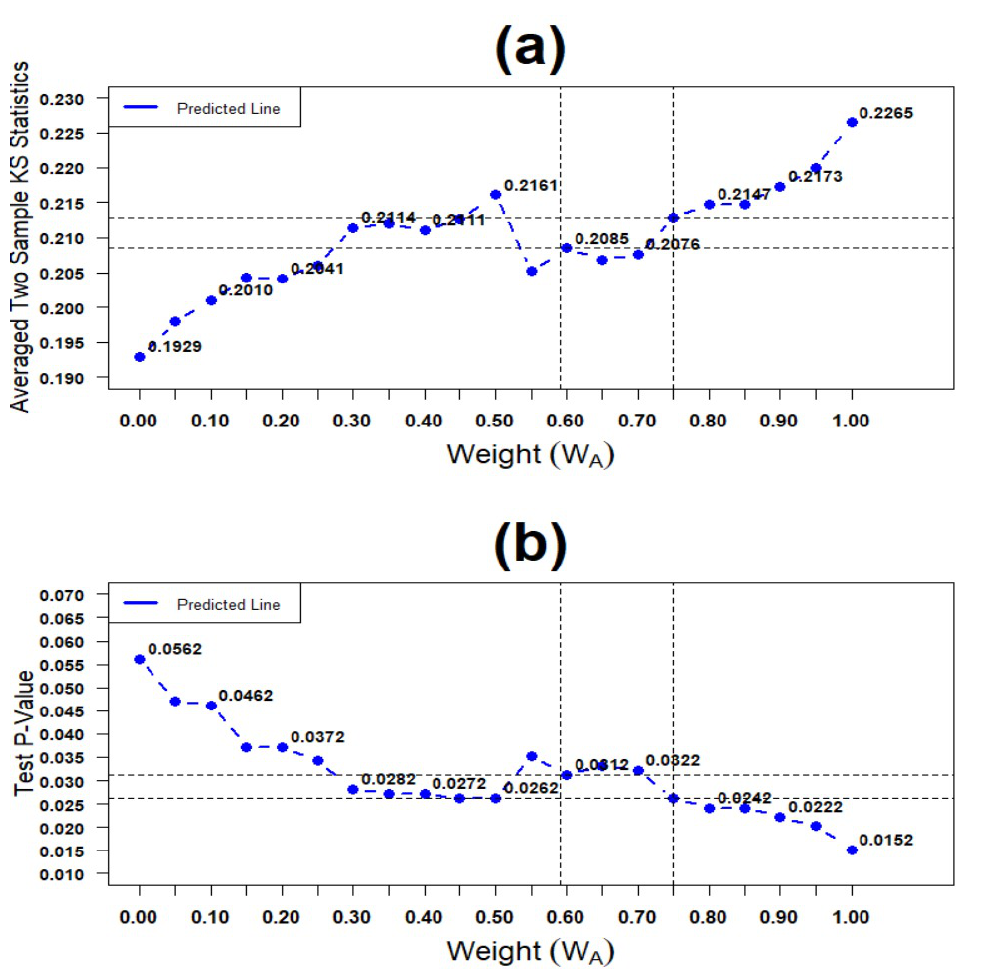
Figure 8. Plot of overall test results of single SSRT versus mixture SSRT: ( a ) Two-sample KS test statistics and ( b ) cut-off point of the test p